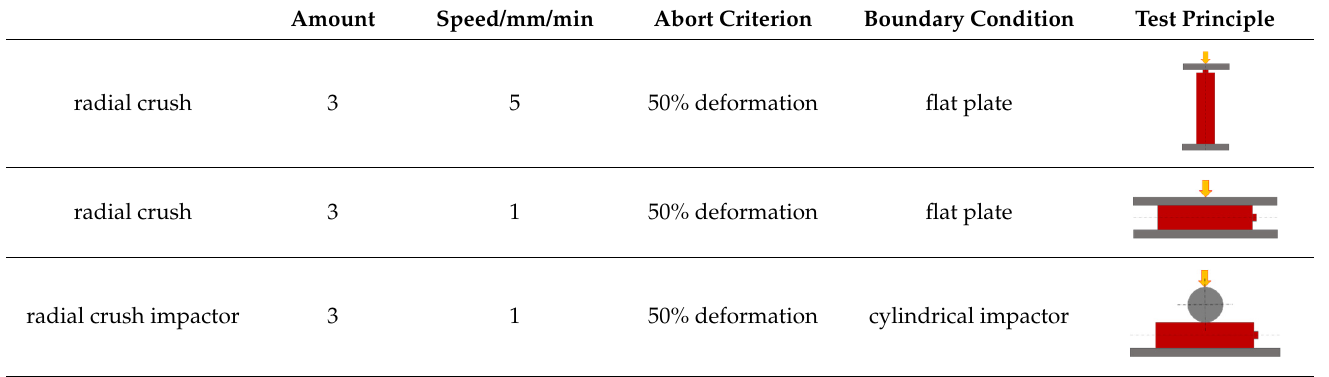
Table 2. Four mechanical abuse tests for type 18650 lithium-ion battery cells.